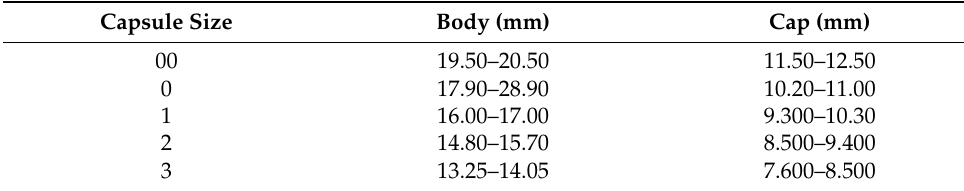
Table 2. Length specification of the segment of hard gelatine capsules.